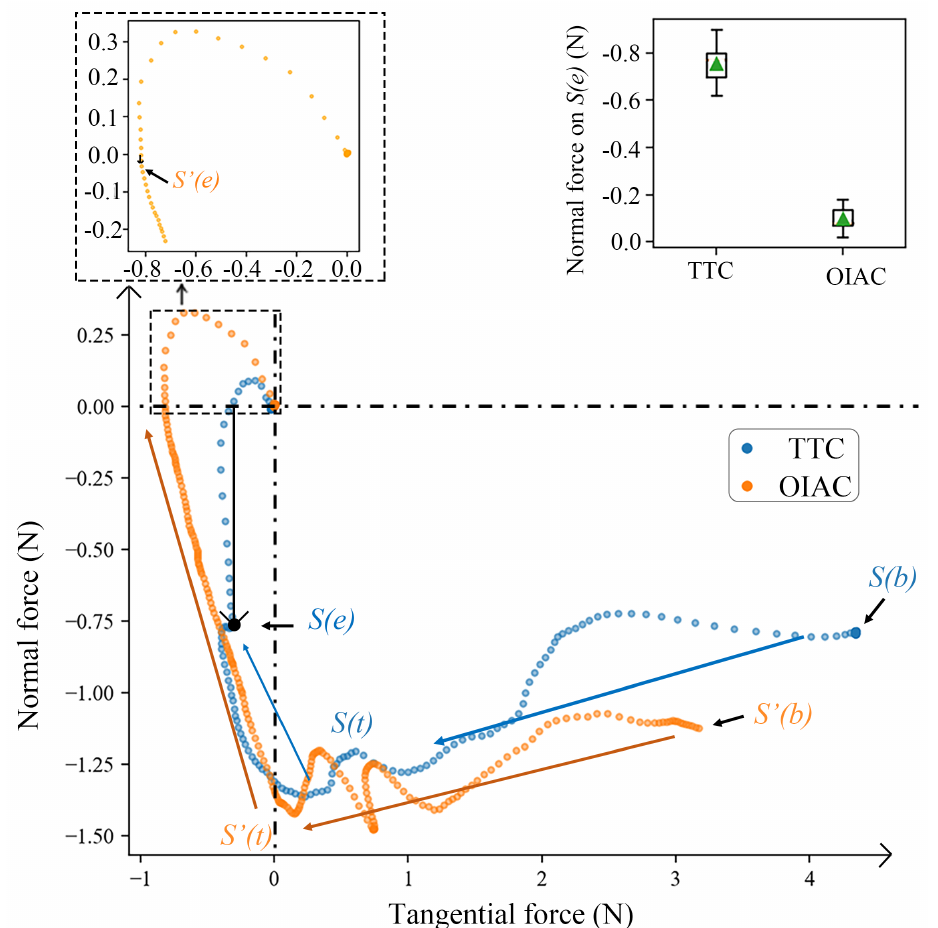
Figure 6. Single − limb detachment force trace and statistical results S ( b ) and S (cid:48) ( b ) : beginning state of detachment under TTC and OIAC, S ( t ) and S (cid:48) ( t ) : turnning state of detachment under TTC and OIAC, S ( e ) and S (cid:48) ( e ) : end state of detachment under TTC and OIAC). The box chart shows the statistical analysis of normal force on S ( e ) and S (cid:48) ( e ) . The green triangles represent the average